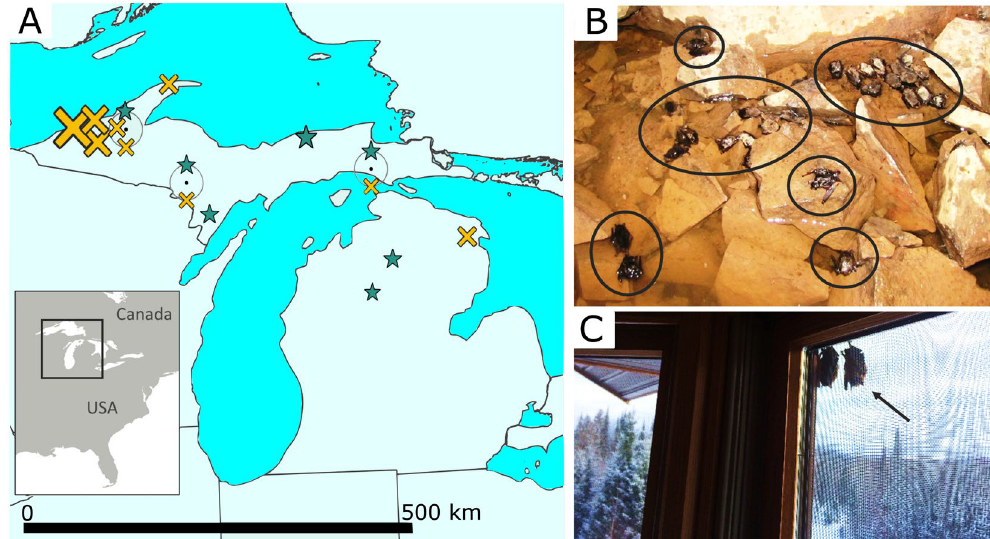
Figure 1. Sampling locations of little brown bats. ( A ) Sequenced survivors ( n = 9, marked by stars) and non-survivors ( n = 29, crosses), jittered around similar collection sites (black dots); the size of the symbol indicates relative differences in the number of samples per site (see Table S1 for details). Survivors undertake short-distance migrations away from hibernacula in spring, which is reflected in their scattered collection locations. Non-survivors are closely associated with underground hibernation sites, with most ( B ) collected within hibernacula (~26 carcasses marked by circles on the floor of a mine), although some ( C ) leave these sites prematurely, like these dead bats on the outer screen of a house < 1 km from a hibernaculum (note the snowy landscape). Photo credits A. Kurta (top) and C. Rockey